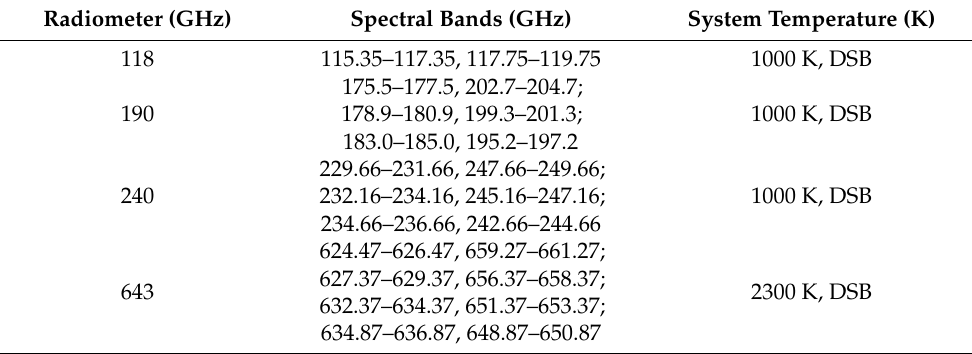
Table 2. The spectral bands of the